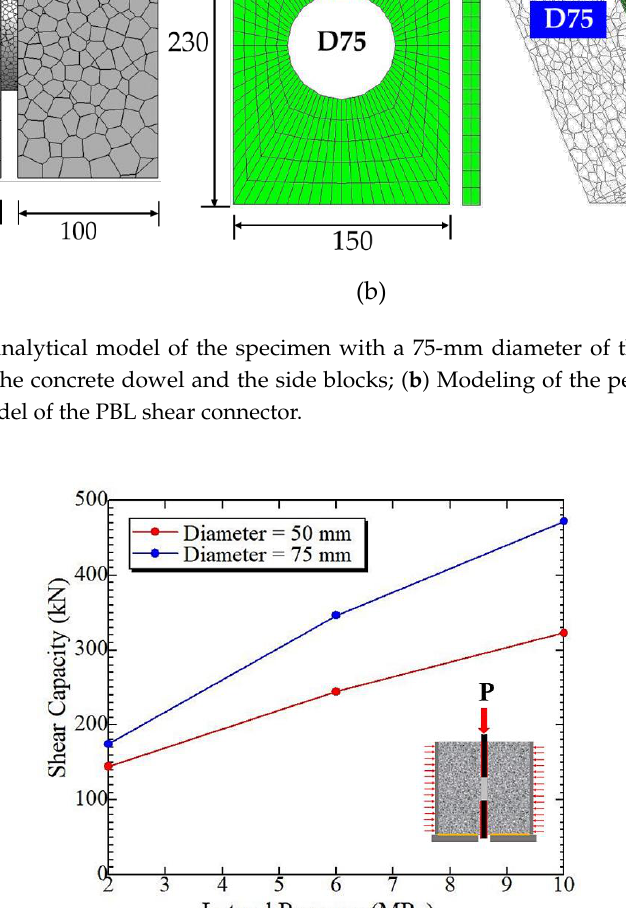
Figure 13. The analytical model of the specimen with a 75-mm diameter of the hole (unit: mm): ( a ) Modeling of the concrete dowel and the side blocks; ( b ) Modeling of the perforated steel plate; ( c ) Analytical model of the PBL shear connector.